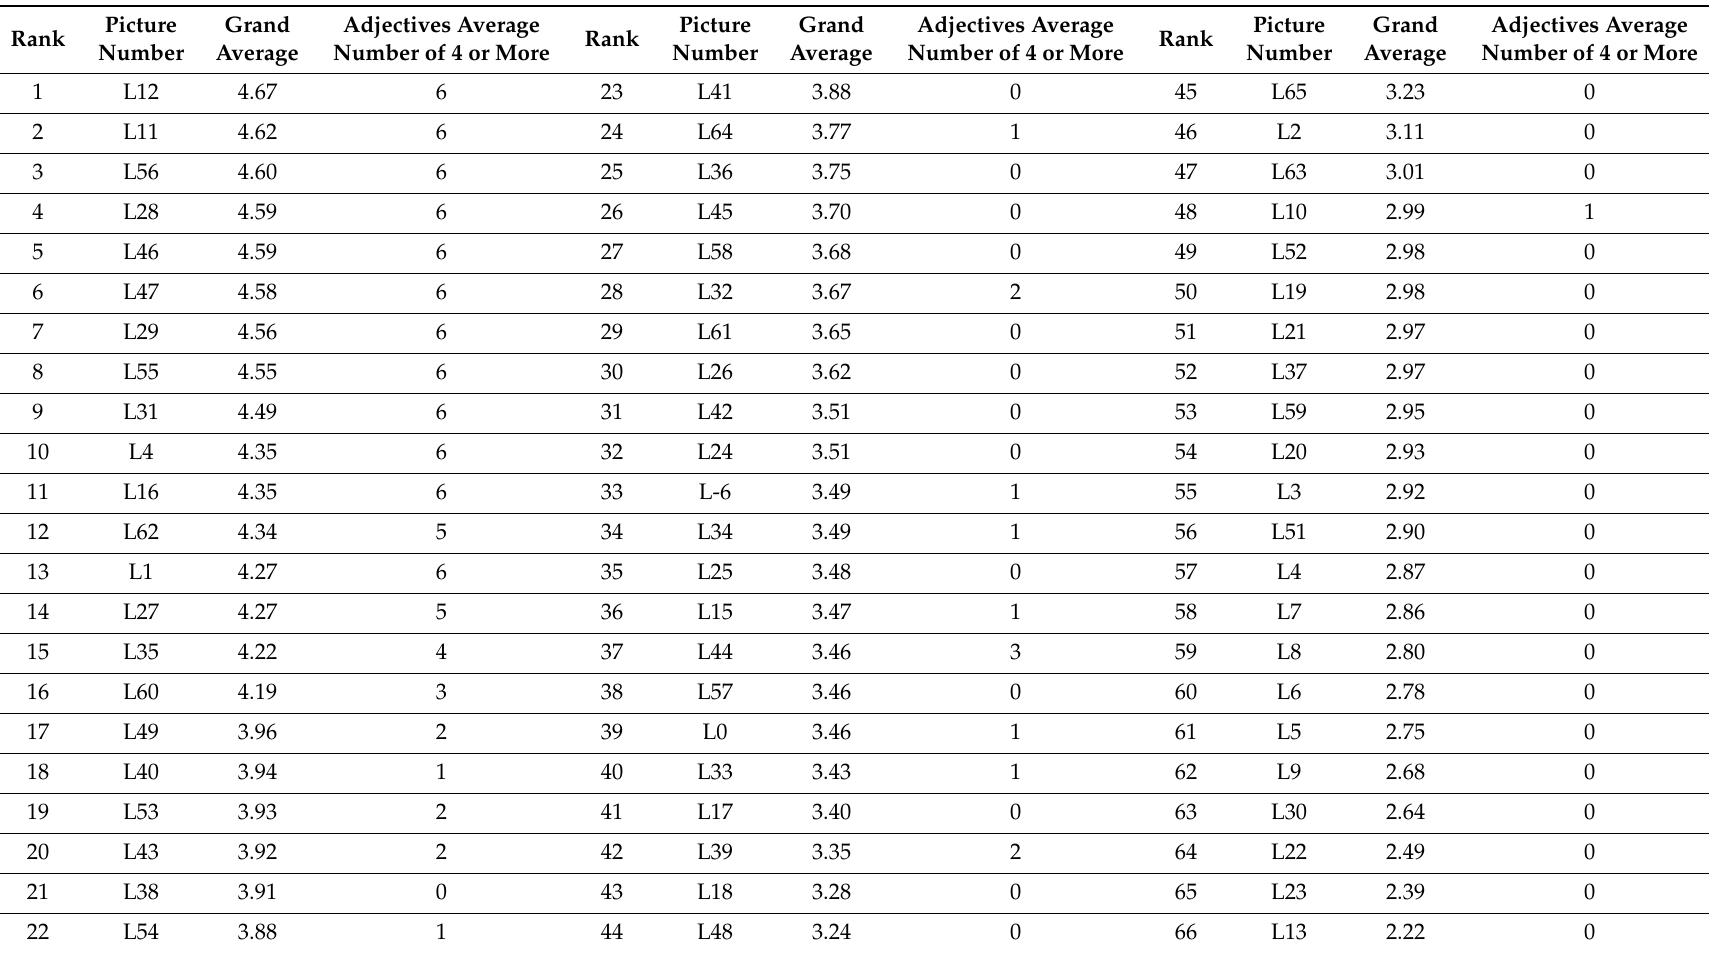
Table 1. SD assessment